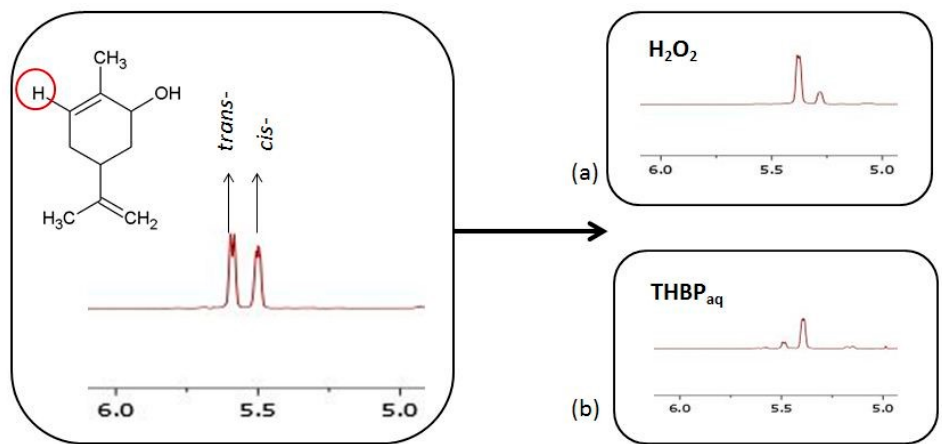
Figure 5. The extracted part of 1 H NMR spectra: (left) mixture of cis - and trans - carveol, reaction mixture with ( a ) H 2 O 2 or ( b ) THBP aq in the presence of complex 2 .